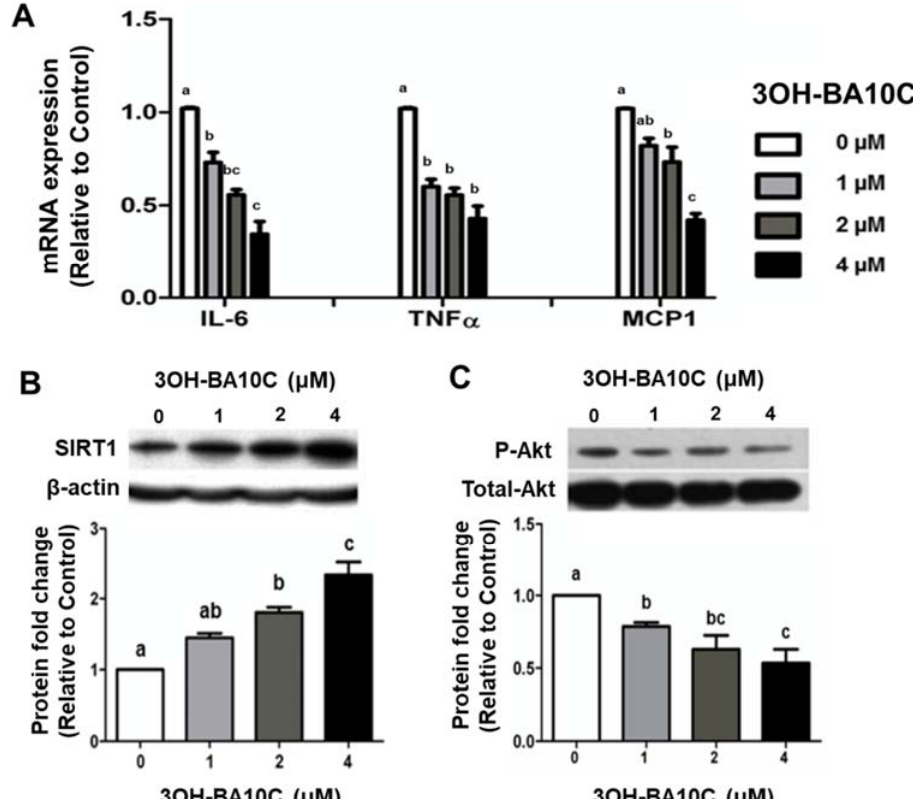
Figure 6. The BCX metabolite 3-OH- β -apo-10’-carotenal (3OH-BA10C) protected against inflamma- tion, increased SIRT1 protein, and decreased phosphorylation of Akt in LPS-stimulated BEAS-2B cells. Shown are the graphical representations of mRNA expression of ( A ) IL-6, TNF- α , and MCP-1 quantified by real-time PCR. β -actin was used as a loading control. Protein expression levels of ( B ) SIRT1 and ( C ) p-Akt were measured by Western blot in BEAS-2B cells pre-treated with 3OH-BA10C (0.5 to 4 µM) following LPS stimulation (10 ng/mL). β -actin and total-Akt were used as controls. Significant differences between groups were analyzed by one-way ANOVA and are denoted by different letters ( p < 0.05). BCX, β -cryptoxanthin; SIRT1, sirtuin 1; TNF- α , tumor necrosis factor- α ; IL, interleukin; MCP-1, monocyte chemoattractant protein 1; SIRT1, sirtuin 1; AKT, protein kinase B; LPS, lipopolysaccharide.